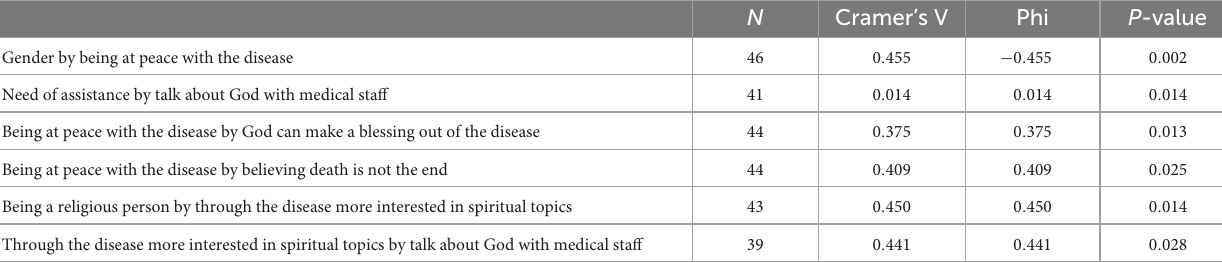
TABLE 4 The results of the chi-square and Fisher’s exact tests for the international group.